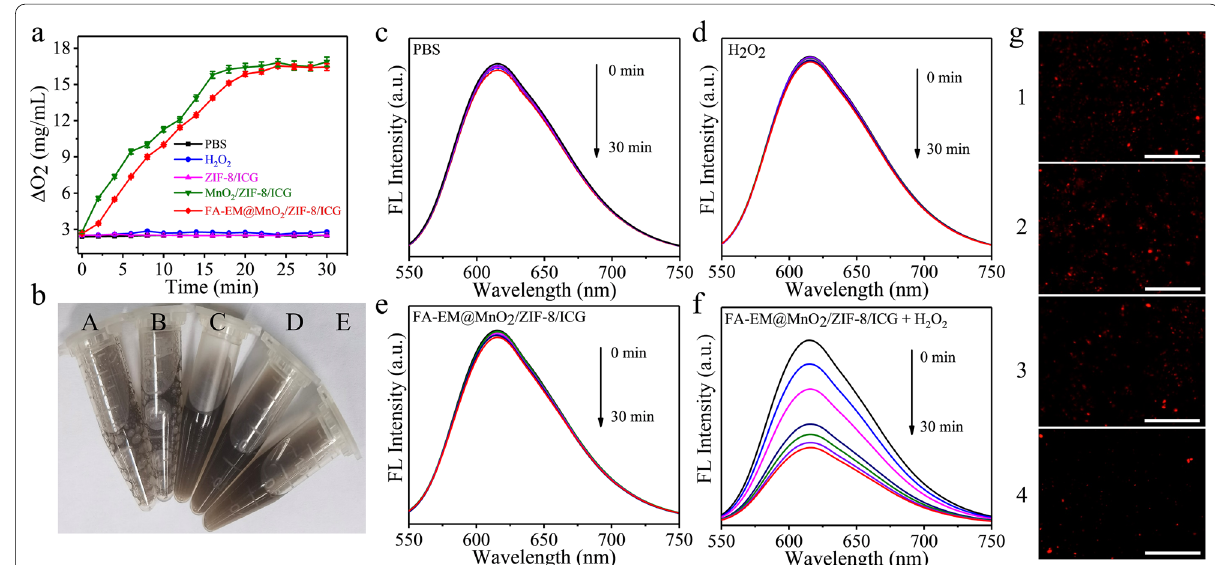
Fig. 4 a H 2 O 2 -triggered O 2 generation in different solutions. b Photograph of H 2 O 2 -triggered O 2 generation in different solutions. (A: MnO 2 /ZIF-8/ ICG in H 2 O 2 solution; B: FA-EM@MnO 2 /ZIF-8/ICG in H 2 O 2 solution; C: ZIF-8/ICG in H 2 O 2 solution; D: MnO 2 /ZIF-8/ICG in PBS solution; E: FA-EM@MnO 2 / ZIF-8/ICG in PBS solution). c Fluorescence spectra of RDPP in PBS ( c ); H 2 O 2 ( d ); FA-EM@MnO 2 /ZIF-8/ICG ( e ); and FA-EM@MnO 2 /ZIF-8/ICG g CLSM images of RDPP in 4T1 cells without any treatments (1); and treated with H 2 O 2 (2); FA-EM@MnO 2 /ZIF-8/ICG (3); and FA-EM@MnO 2 /ZIF-8/ ICG H 2 O 2 (4). Scale bars: 300 +